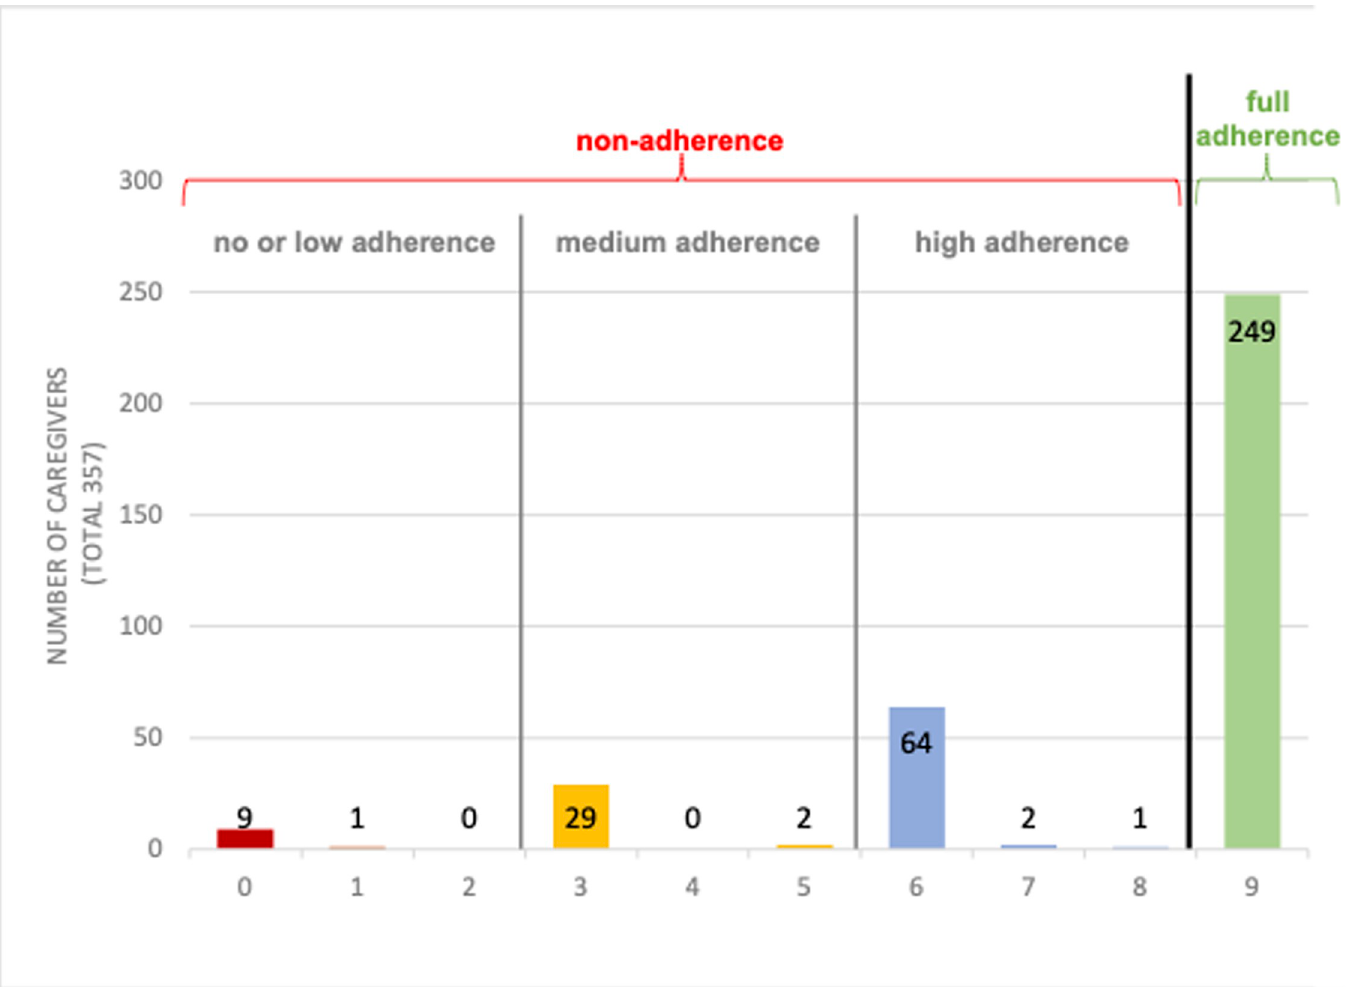
Fig 2. Distribution of adherence behavior: The total number of tablets administered per